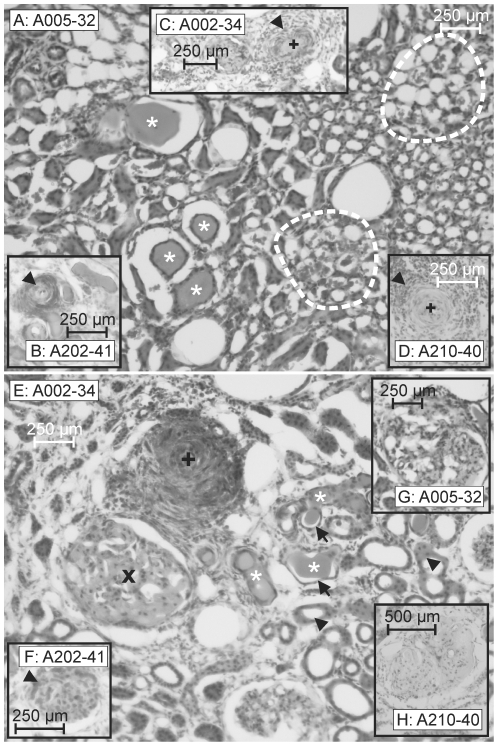
Structural damage of the kidney medulla and kidney cortex in SHRSP.

Figure 5
 demonstrates the main histopathological changes in the kidney of SHRSP. A shows an area of dilated peritubular capillaries with intravasal erythrocyte aggregations in the kidney medulla (marked by white dotted lines). Note tubular protein cylinders (white asterisks) in the kidney medulla (A) and kidney cortex (E) indicating tubular damage. In addition, tubular damage is characterized by flattening and atrophy of the tubular epithelial cells (black arrows, E). Note in contrast the normal cubic epithelium of non damaged tubules (black arrow heads, E). In B–E chronological stages of thrombotic microangiopathy are illustrated. B
&
E demonstrate early, C
&
D demonstrate advanced stages. In B
&
E occluded arterioles with concentric thickened and hemorrhagic tunica media (“onion-skin”; black arrow head in
B; black cross in
E) are shown. C demonstrates a fresh microthrombosis (black cross) with excentric hemorrhage and D shows an older microthrombosis (black cross). Note the accompanying leukocyte leakage into the perivascular interstitium (black arrow heads, C
&
D). In E–H chronological stages of glomerulosclerosis are illustrated. F demonstrates an early stage marked by erythrocyte sticking in glomerular capillaries (black arrow head); in E, G
&
H advanced stages with capillary obliteration and increased mesangial matrix (black x, E) leading to a segmental (G) or more global (H) glomerulosclerosis. A005-32: animal number 5, 32 weeks old.